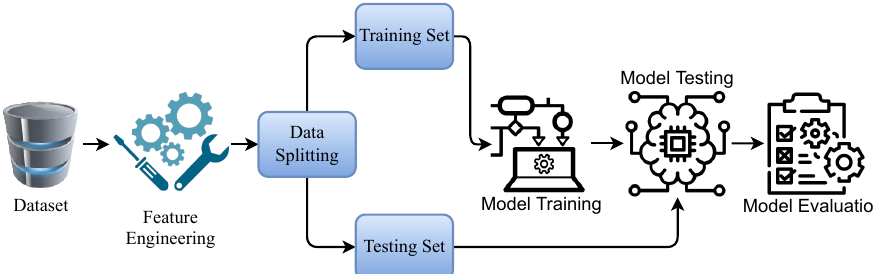
Figure 1. Flow of the adopted methodology for confusion